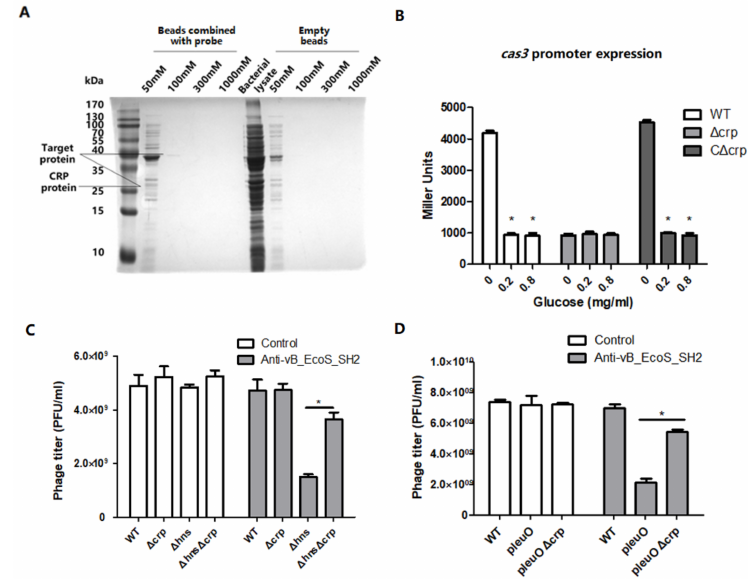
Figure 5. cAMP receptor protein (CRP) positively regulates the transcription of gene cas3 to affect phage infection. ( A ) The CRP protein was pulled down by magnetic beads bonded to the probe. In the upper protein band, 8 potential regulators were identified, and in the lower protein band, 63 potential regulators were identified. ( B ) The β -gal activity of the cas3 promoter was measured by reporter plasmids in WT, ∆ crp (EC61), or C ∆ crp (EC71) cultured in LB media supplemented with 0, 0.2, or 0.8 mg / mL